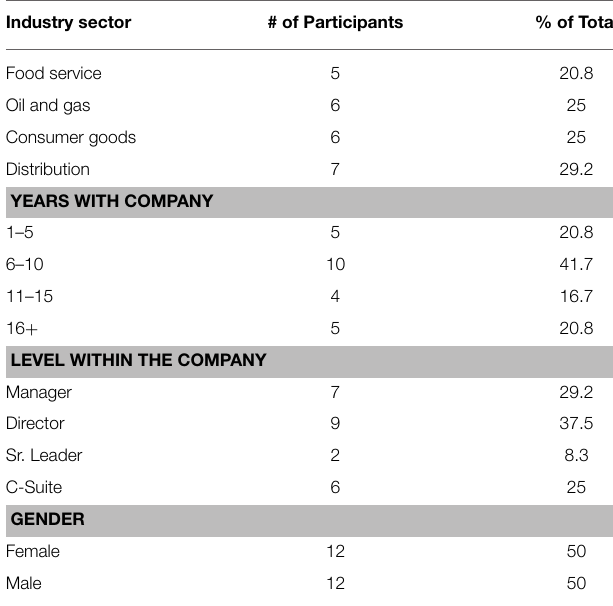
Group 2—Socio-emotional—13 respondents Responses indicating a Socio-emotional Nature